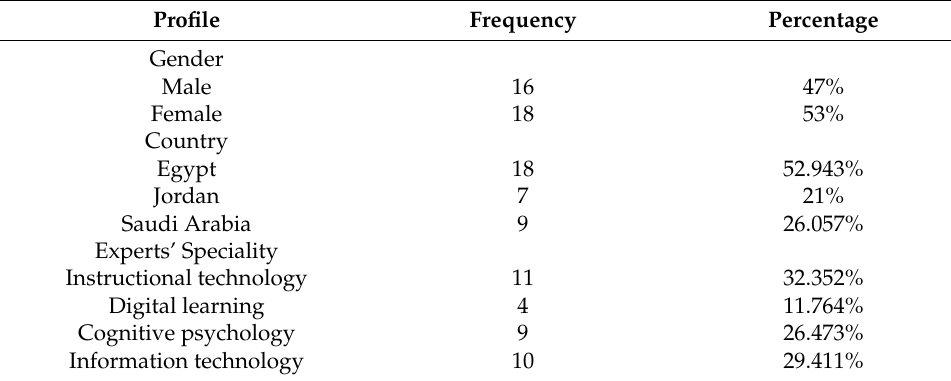
Table 1. Experts’ demographical